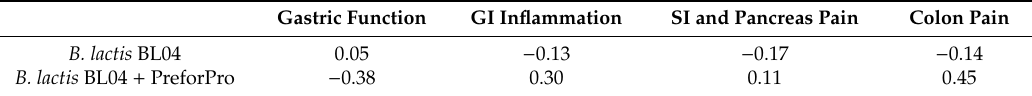
Table 5. Effect size (Cohen’s d ) of treatments relative to the placebo. Gastric Function GI Inflammation